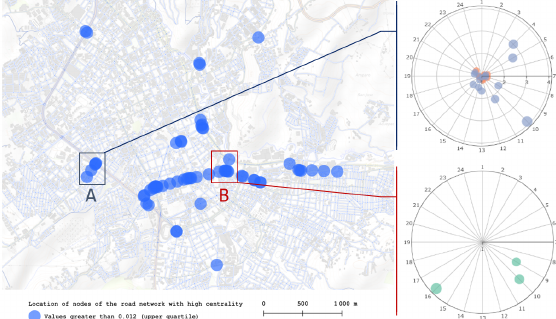
Figure 7. Example of the use of the AVIMEU tool to analyze the convergence of paths in the points with high centrality of the road